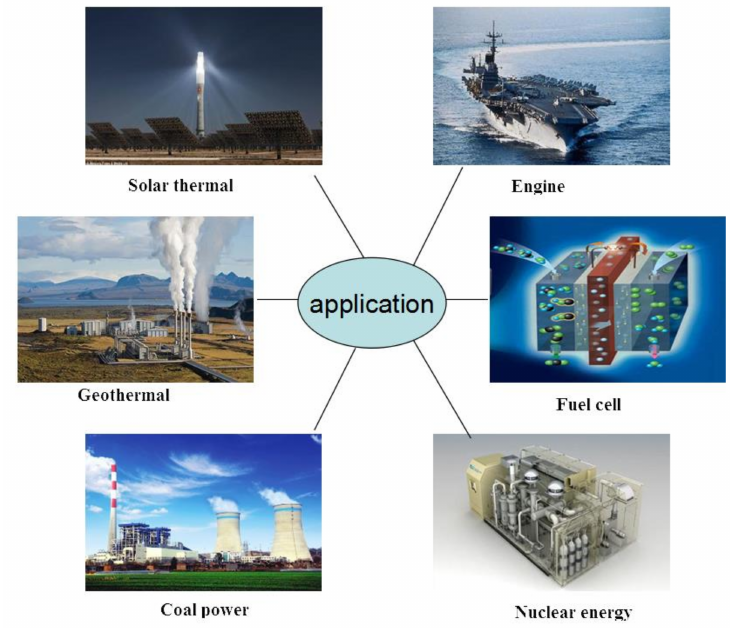
Figure 1. Application fields of the supercritical carbon dioxide Brayton